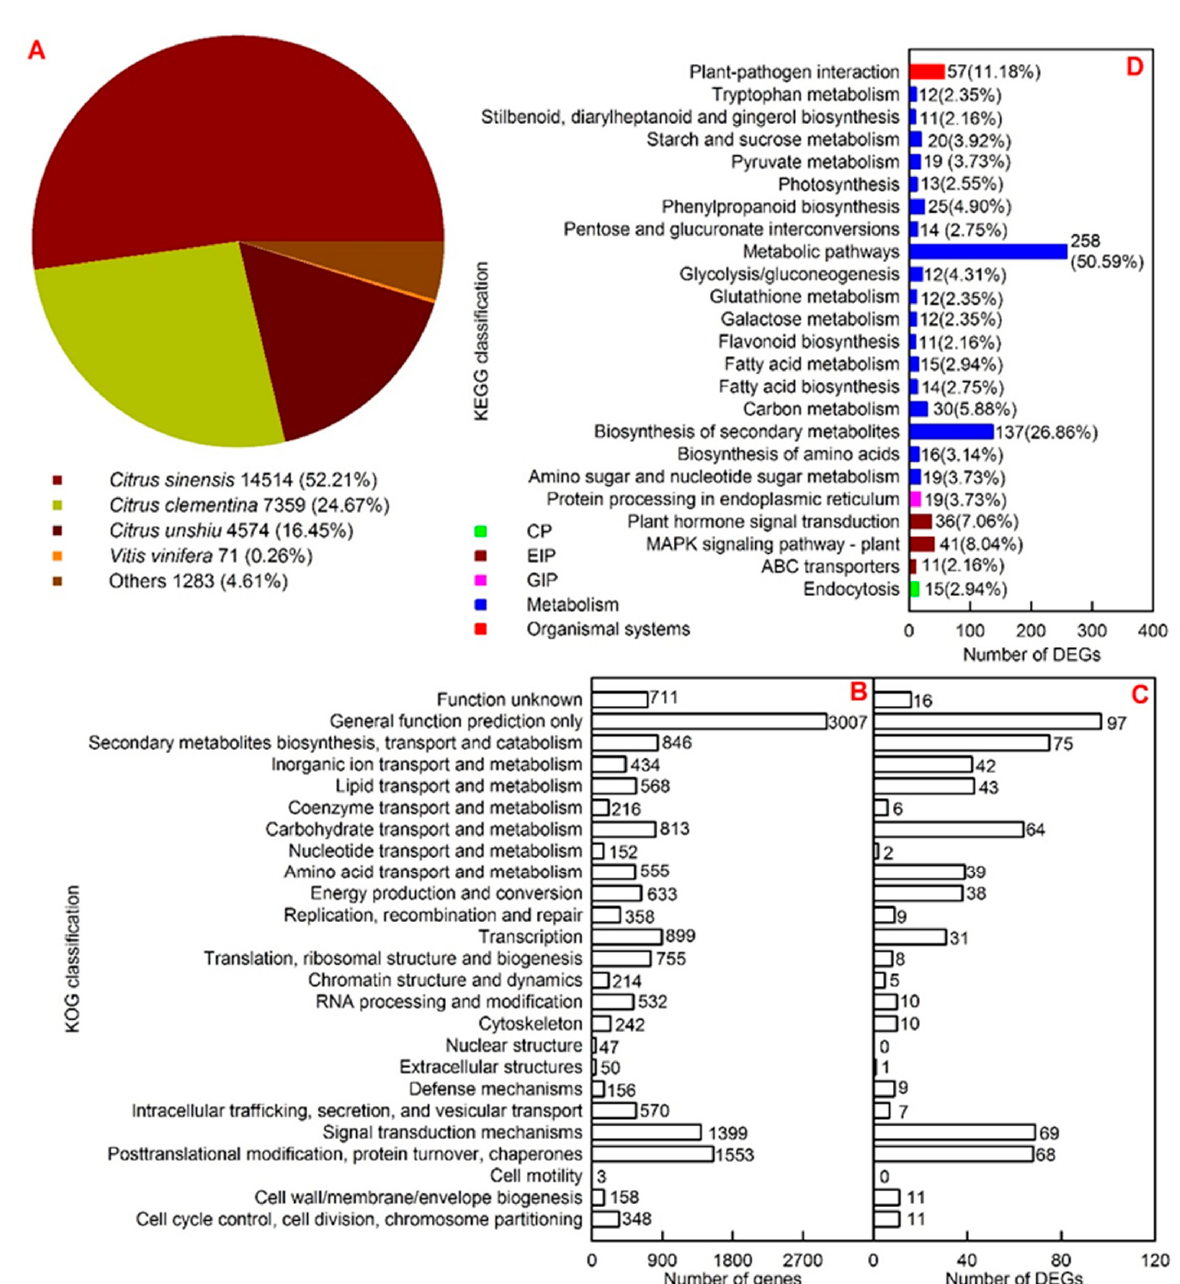
Figure 4. Species distribution of the top Blast hits for C. grandis sequences ( A ), KOG classification of all annotated genes in C. grandis leaves ( B ) and DEGs in LCGSEC ( C ), and KEGG classification of DEGs in LCGSEC ( D ).